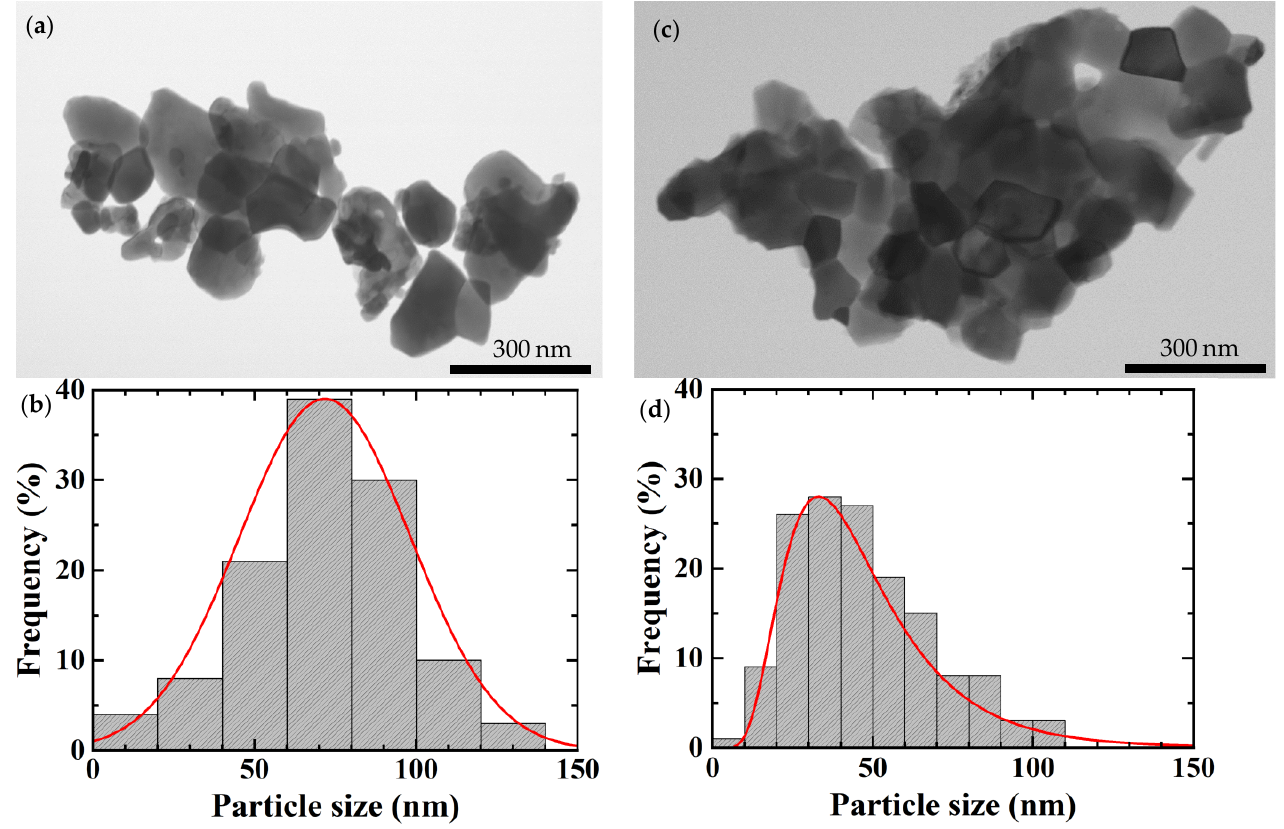
Figure 2. TEM image and particle size distribution of La 2 − x Sr x CuO 4 nanoparticles with x = 0.20 under different sintering conditions ( a , b ) sintering condition of 1073 K for 180 min ( c , d ) sintering condition of 973 K for 180 min.